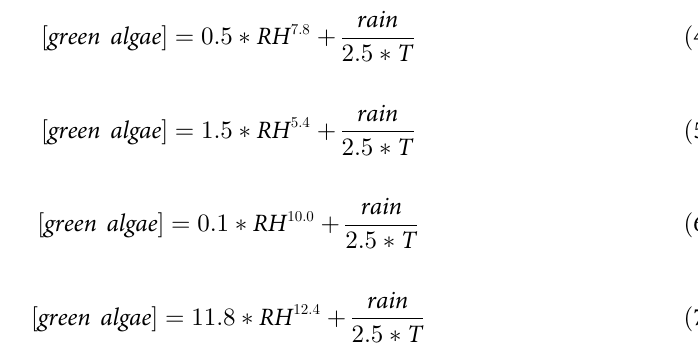
Different values of c were tested to fit the data. It was noted that c is around 20 in fall-winter and 40 for spring. This is consistent with previous observations that rain leads to higher bio- logical development in winter. Thus, as there is approximately a factor 2 between average tem- perature (T) during the spring period (16.4˚C) and during the fall-winter (7.9˚C), c was estimated to be equal to 2.5 / T to take into account this seasonal effect: